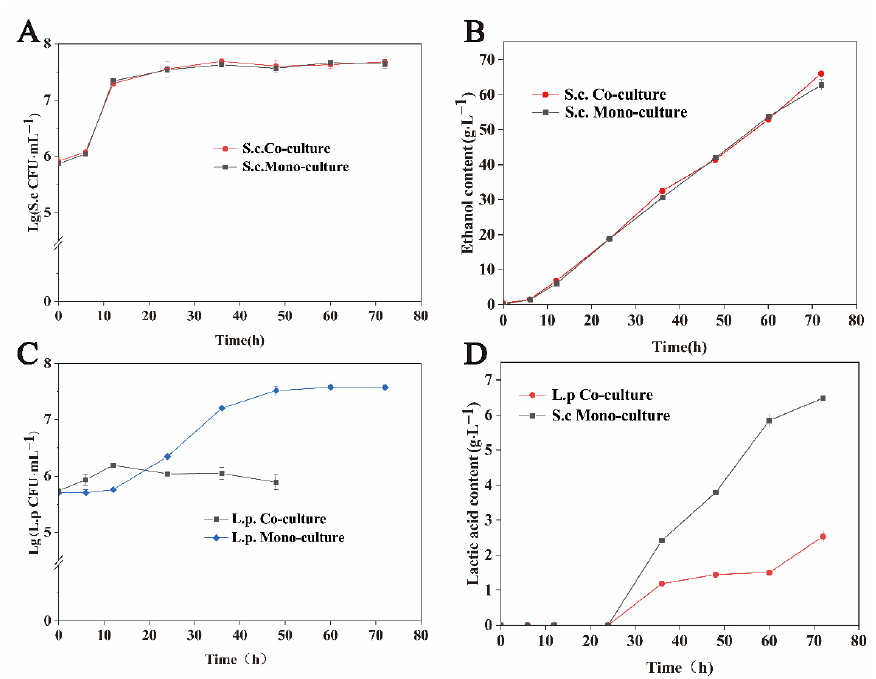
Figure 1. Effects of monoculture and co-culture on the growth and key metabolite production of S. cerevisiae and L. panis . ( A ) Cell growth of S. cerevisiae under monoculture (inoculation with 10 6 CFU · mL − 1 of S. cerevisiae ) and co-culture (inoculation with both 10 6 CFU · mL − 1 of S. cerevisiae and 10 6 CFU·mL − 1 of L. panis ) conditions. ( B ) Cell growth of L. panis under monoculture (inoculation with 10 6 CFU · mL − 1 of L. panis ) and co-culture (inoculation with both 10 6 CFU · mL − 1 of S. cerevisiae and 10 6 CFU · mL − 1 of L. panis ) conditions. ( C ) The contents of ethanol produced by S. cerevisiae under monoculture (inoculation with 10 6 CFU · mL − 1 of S. cerevisiae ) and co-culture (inoculation with both 10 6 CFU · mL − 1 of S. cerevisiae and 10 6 CFU · mL − 1 of L. panis ) conditions. No L. panis was detected at 60 and 72 h under co-culture conditions. ( D ) The contents of lactic acid produced by L. panis under monoculture (inoculation with 10 6 CFU · mL − 1 of L. panis ) and co-culture (inoculation with both 10 2 CFU · mL − 1 of S. cerevisiae and 10 6 CFU · mL − 1 of L. panis )